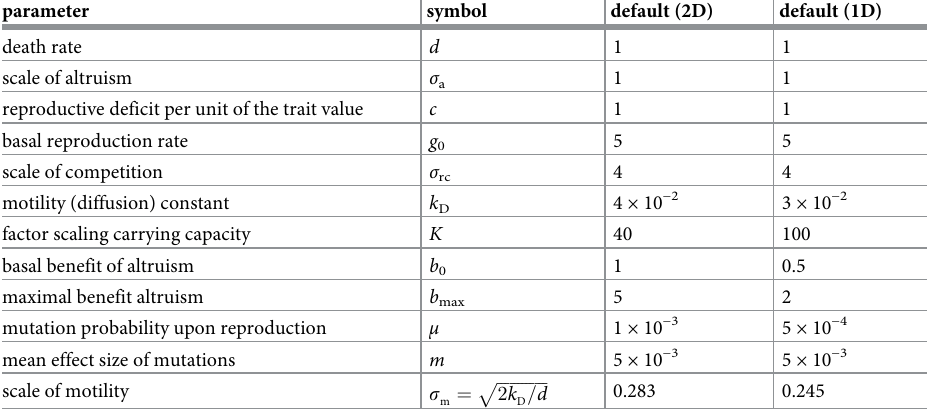
Table 1. Model parameters and their default values for simulations with the 1D and 2D habitat.